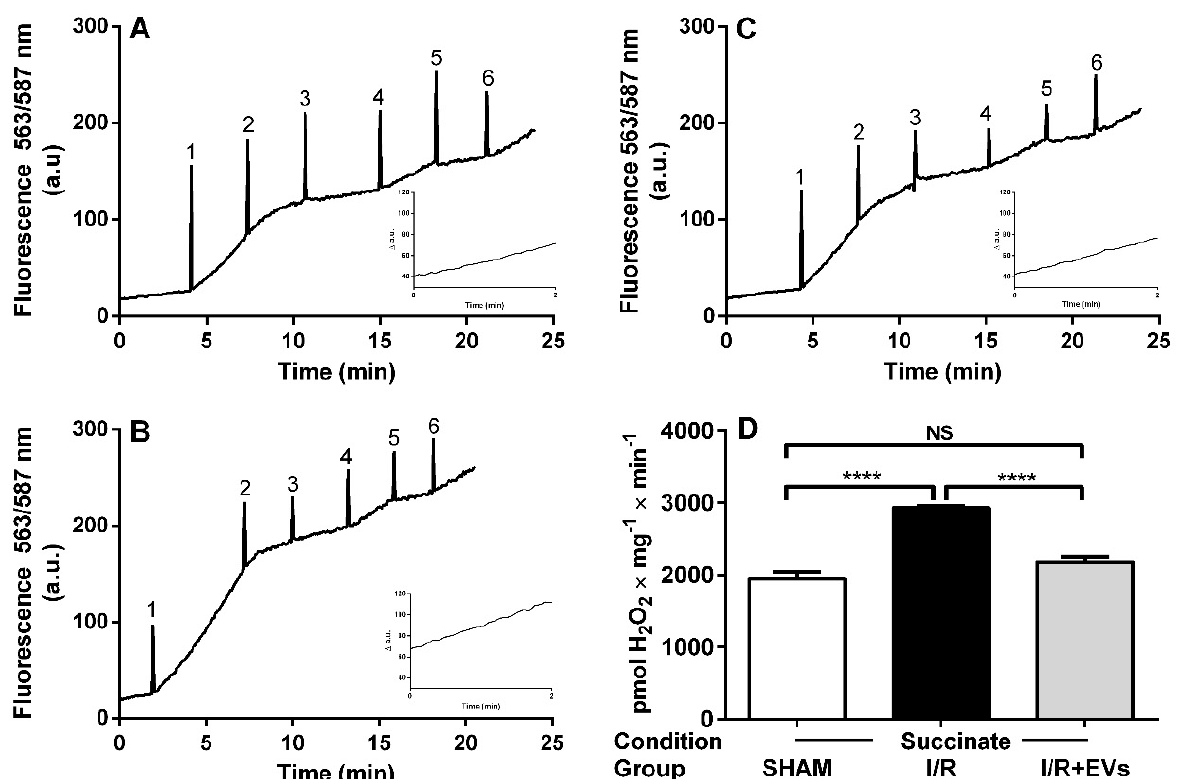
Figure 3. Generation of O 2 •− in renal mitochondria 24 h after ischemia/reperfusion (I/R). Representative time courses of H 2 O 2 formation from the O 2 •− generated in renal cortex corticis mitochondria during different respiratory states, which were elicited by successive additions of substrates/inhibitors. ( A ) SHAM rats. ( B ) I/R conditions. ( C ) I/R + EVs; EVs were injected at the beginning of reperfusion. The numbers (spikes) indicate additions to the medium. 1:10 mM succinate; 2:0.1 mM ADP; 3:1 mM ADP; 4:0.2 µ g/mL oligomycin; 5:1.5 µ M FCCP; 6:2.5 µ M Antimycin A. The insets allow a better comparison of the rate of formation of H 2 O 2 over 2 min after the addition of succinate. The dismutation reaction 2O 2 •− + 2H + → H 2 O 2 + O 2 was non-limiting because an excess of superoxide dismutase (SOD) (60 U/mL) was added to the reaction medium. Standard curves were obtained by successive additions of 10 nM H 2 O 2 pulses at 2 min time intervals, thereby allowing calculation of rates in pmol H 2 O 2 × mg − 1 × min − 1 (see the following figure). ( D ) Quantification of the H 2 O 2 formation after addition of succinate (insets). Bars are mean ± SEM; n = 7 (SHAM); n = 7 (I/R); n = 5 (I/R+EVs). Means were compared using one-way ANOVA followed by Tukey ′ s test. **** p < 0.0001; NS: not significant.